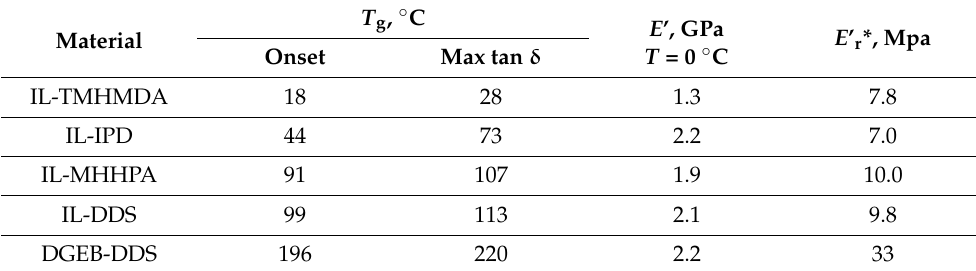
Table 4. Glass transition temperatures and storage moduli obtained from